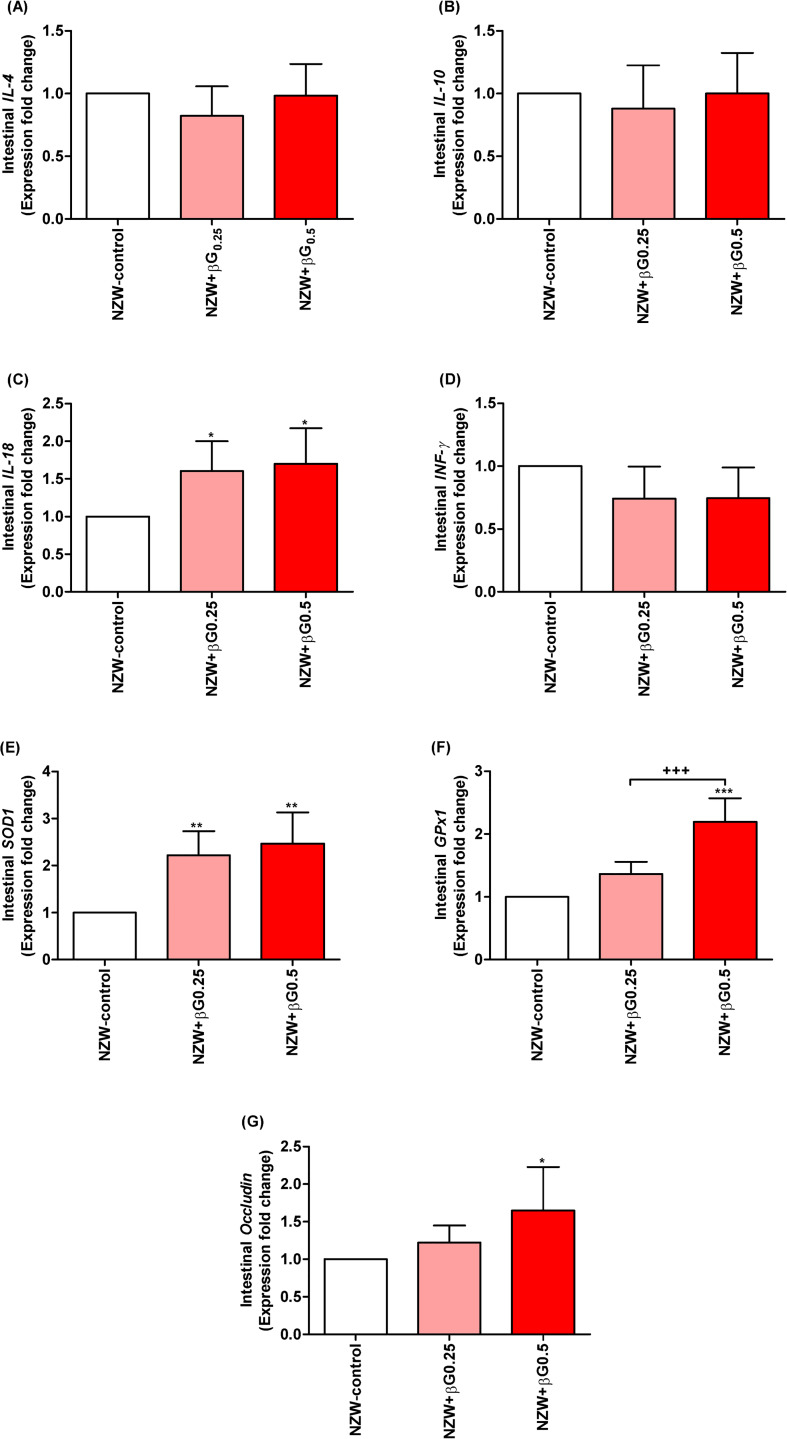
RT-PCR validation of the intestinal (A) interleukin-4 (IL-4), (B) interleukin-10 (IL-10), (C) interleukin-18 (IL-18), (D) interferon-γ (IFN-γ), (E) superoxide dismutase 1 (SOD1), (F) glutathione peroxidase 1 (GPx1), and (G) occludin genes in NZW rabbits. *P < 0.05, **P < 0.01 and ***P < 0.001 vs. control. +++P < 0.001 vs. NZW+βG0.25. Statistical analysis was performed using one-way ANOVA and Tukey's post hoc test for multiple comparisons.